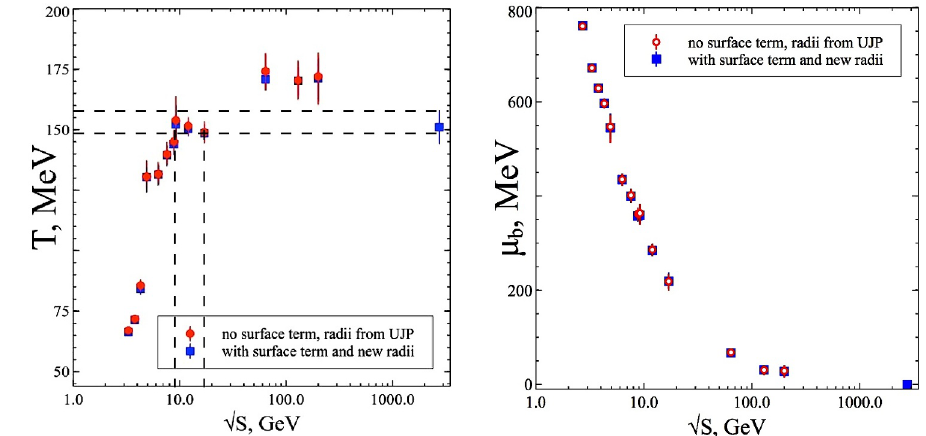
Figure 1. Left panel: The CFO temperature as a function of the collision energy found in [21] within MHRGM1 (circles) and MHRGM2 (squares). The horizontal dashed lines correspond to the range of the (3)CEP temperature values found in [23]. The vertical dashed lines indicate the corresponding values of the collision energy at which the CEP can be reached (see text for details). Right panel: The same as in the left panel, but for the baryonic chemical